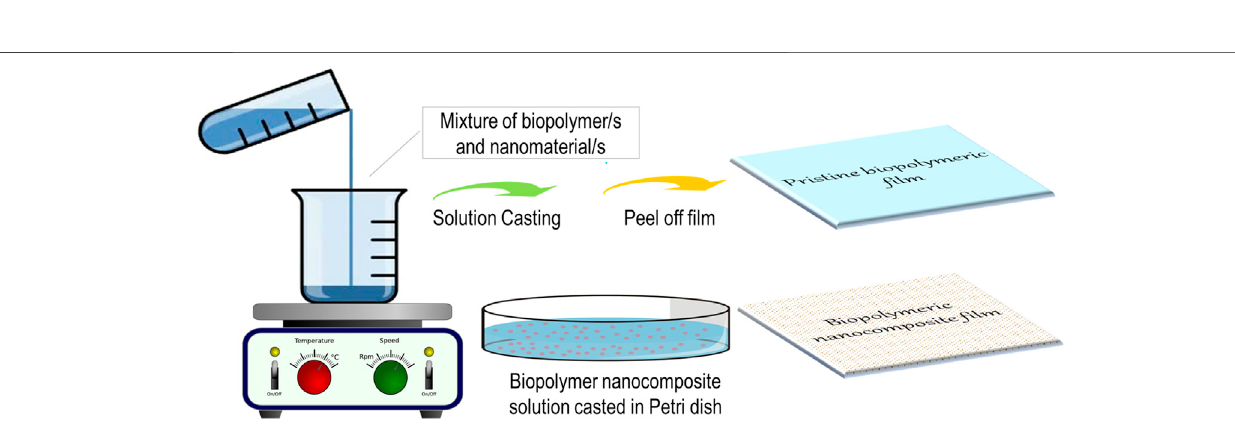
Frontiers in Materials |